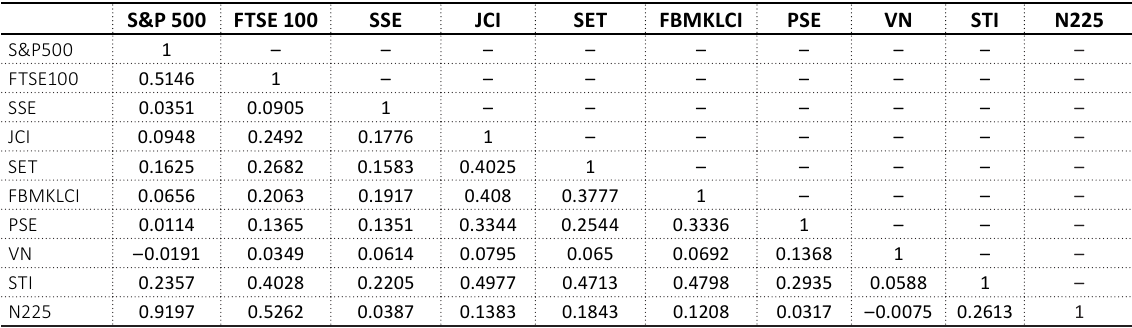
Table 2. Unconditional correlation matrix of market